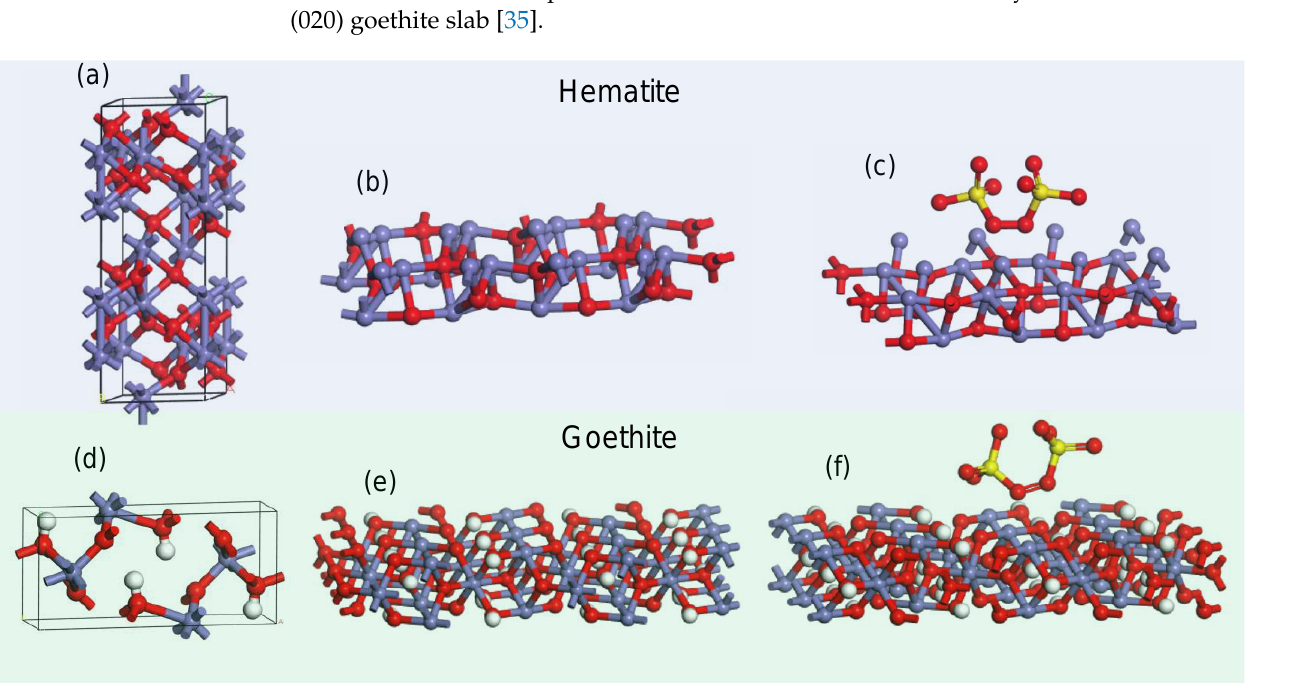
Figure 6. Conventional crystal structure of ( a ) hematite, ( b ) the crystal slab surface of the (104) plane, and ( c ) with PS molecule on the slab surface. Conventional crystal structure of ( d ) goethite, ( e ) the crystal slab surface of the (020) plane, and ( f ) with PS molecule on the slab surface. Atom labels: Fe (blue), O (red), H (white), and S (yellow).